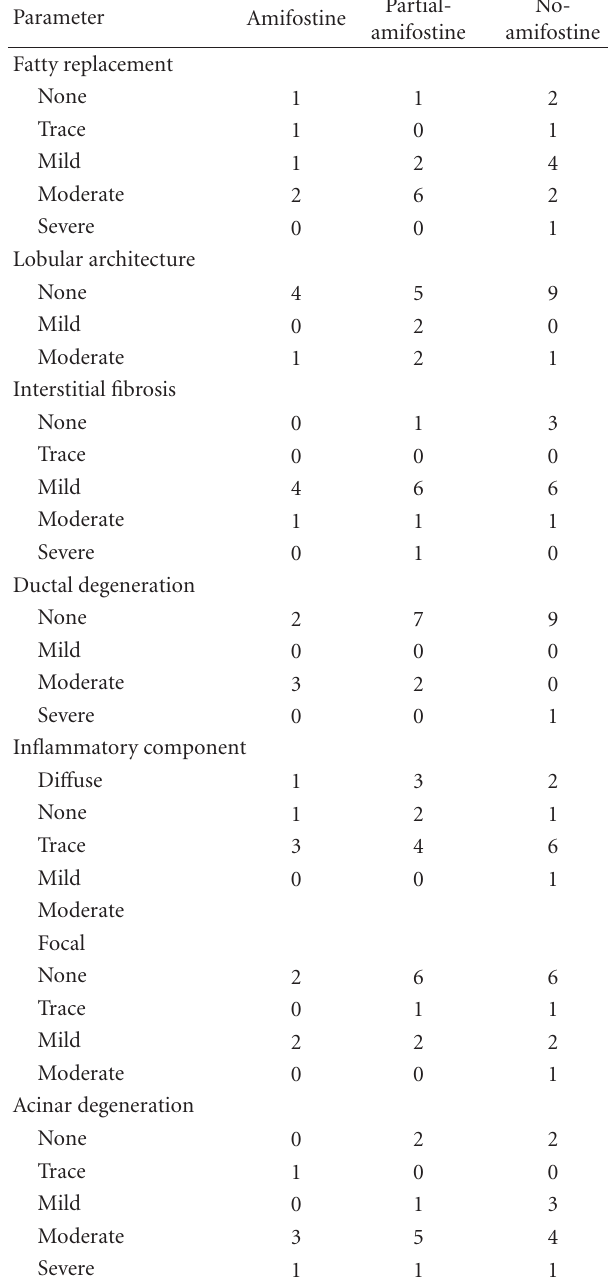
Table 2: Tabulated scoring of the histologic analysis.